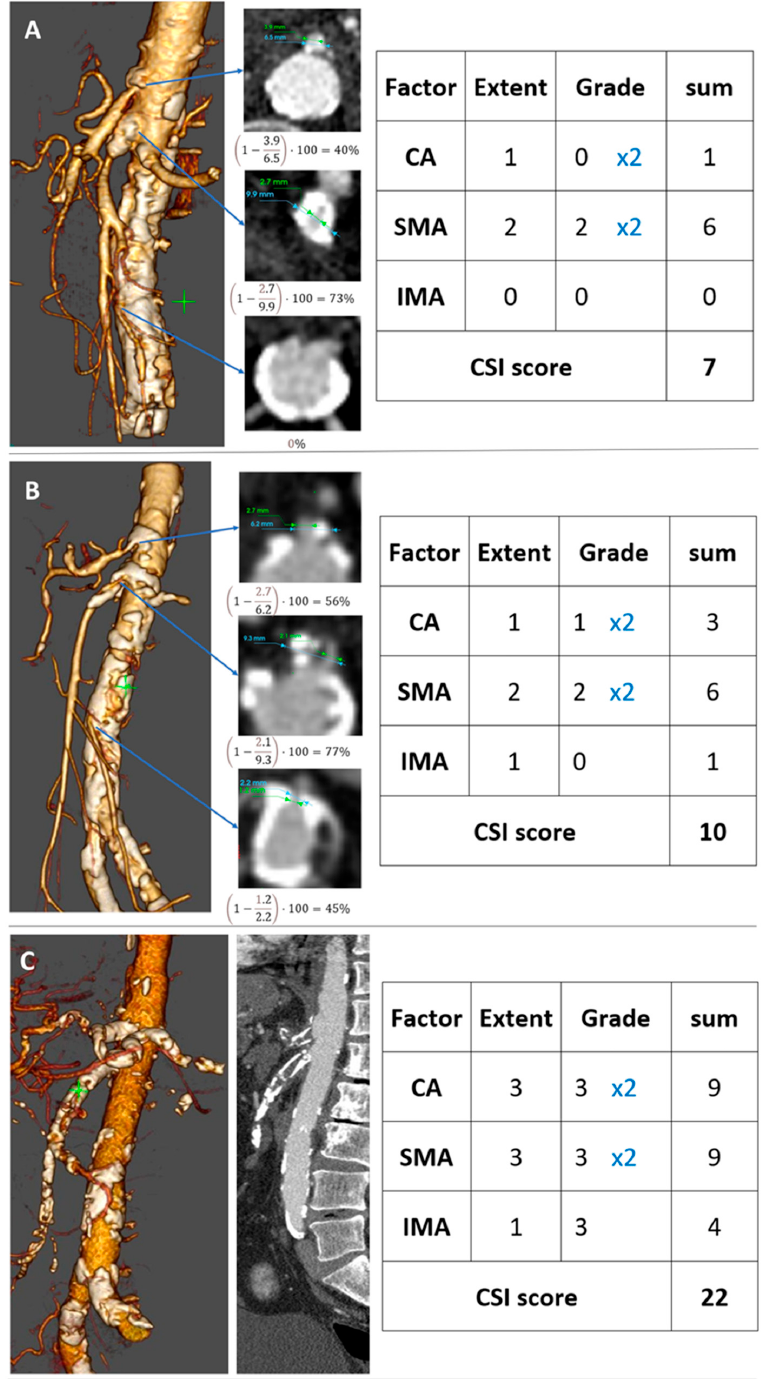
Figure 3. 2D and 3D reconstructed CT angiography with sample calculations of the stenosis grade of the visceral arteries and the CSI-score for three patients. ( A ) Showing ostial (40%) stenosis of the CA, proximal (73%) of the SMA, with no stenosis of the IMA. ( B ) Showing ostial (56%) stenosis of the CA, proximal (77%) of the SMA, and ostial (45%) of the IMA. ( C ) Showing extended occlusion of the CA and SMA and ostial occlusion of the IMA.